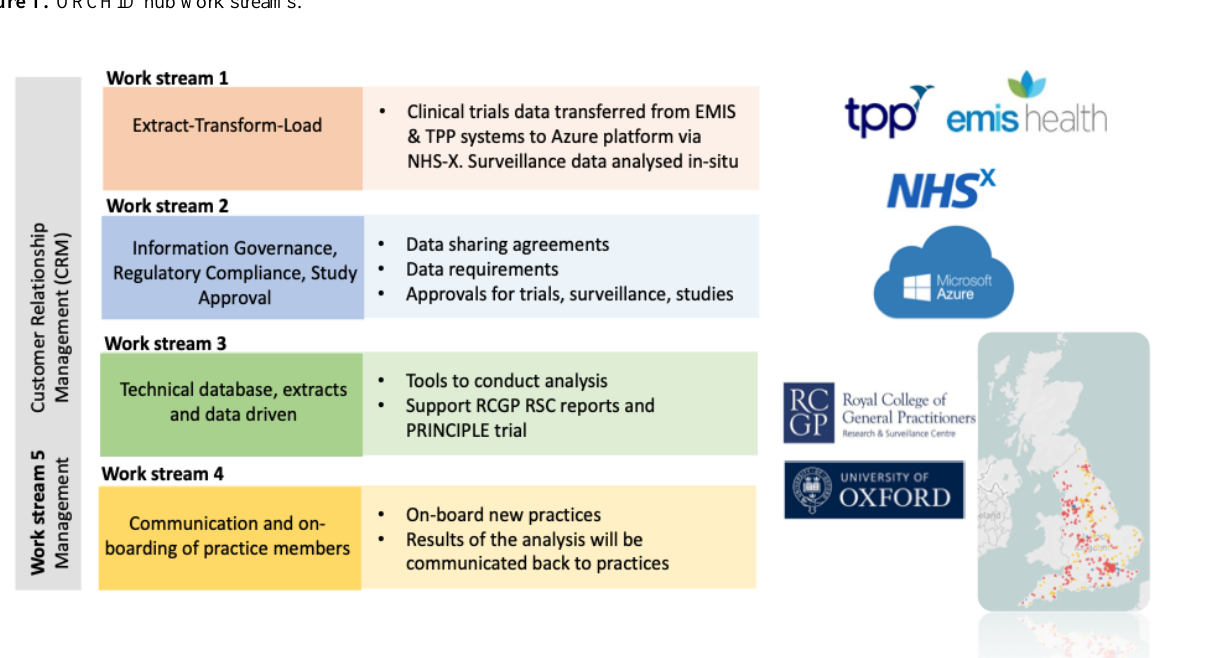
Figure 1. ORCHID hub work